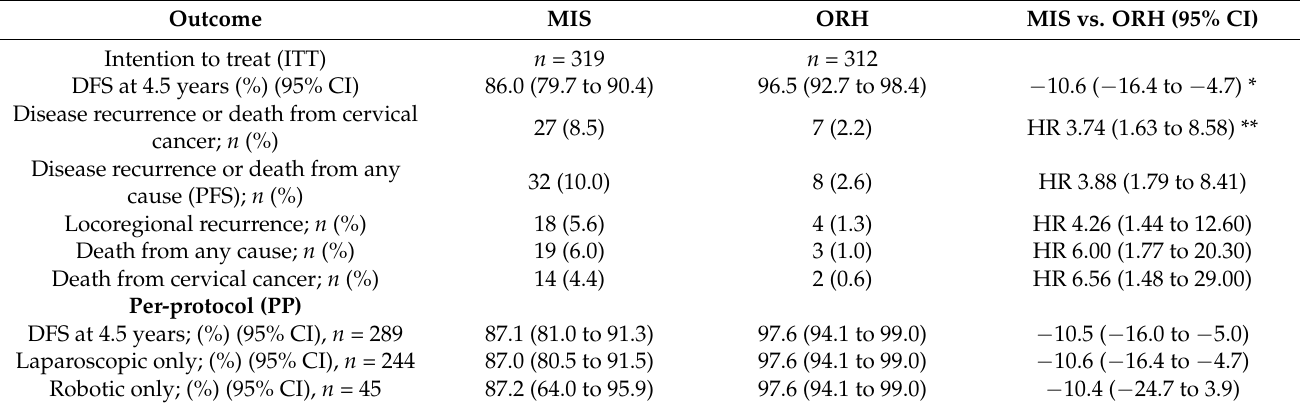
Table 2. Results of the LACC